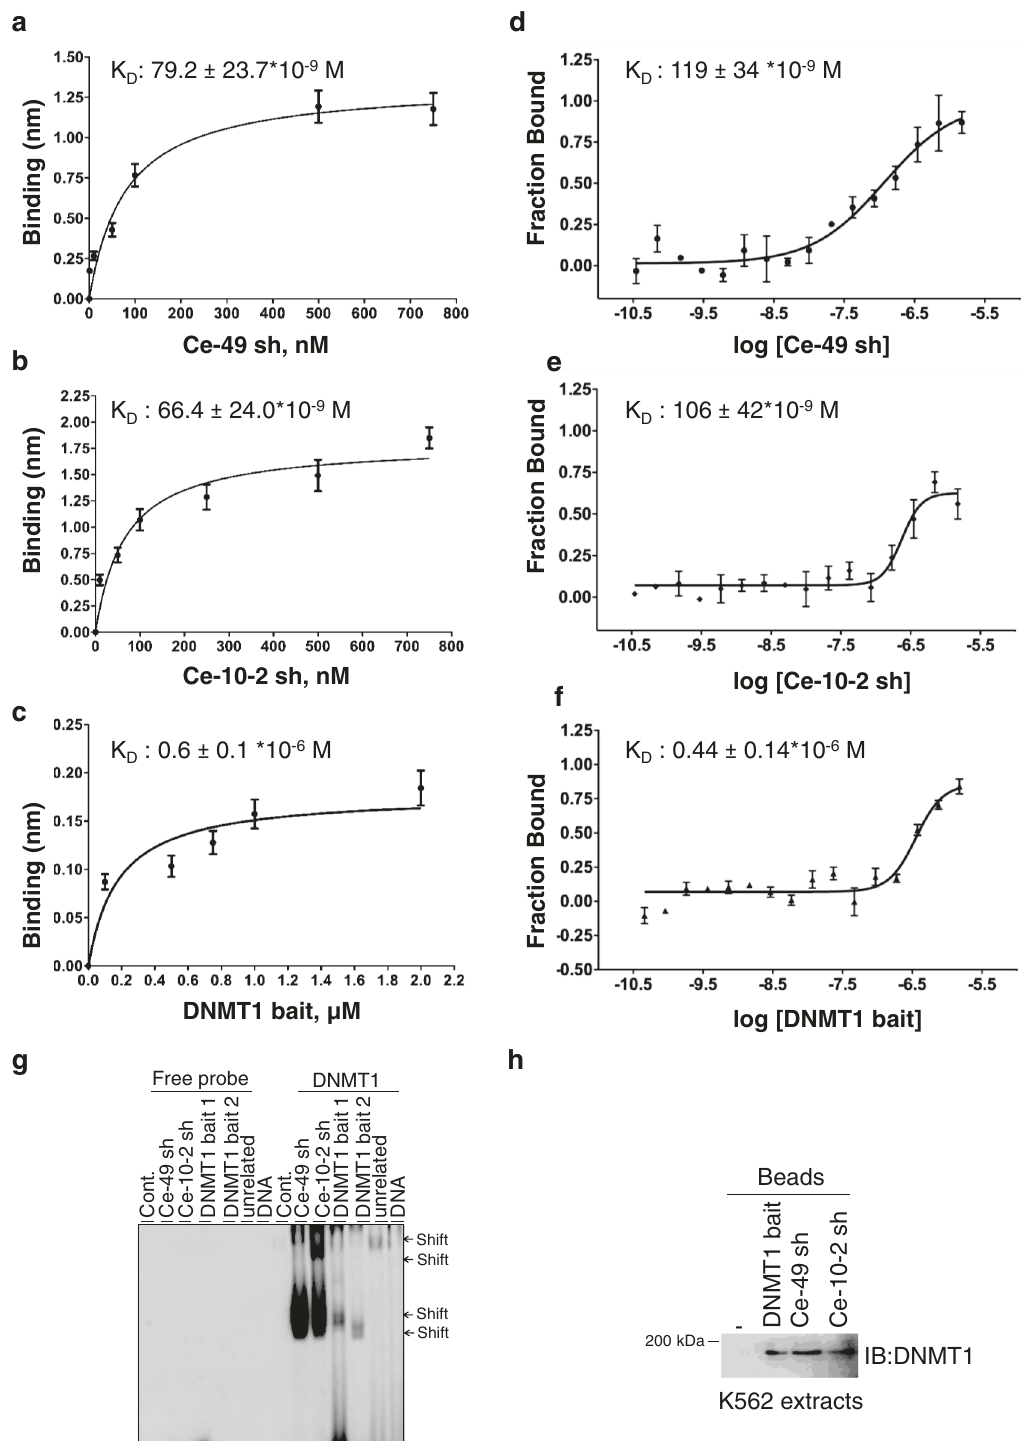
Fig. 3 | AptaDiR af fi nity and in vivo binding to DNMT1. Binding curves derived from BLI analyses of Ce-49 sh ( a ), Ce-10-2 sh ( b ) or DNMT1 bait ( c ). Curves were fi tted with a 1:1 binding model using GraphPad Prism 6. Individual values and the errors calculated by fi tting binding curves using Blitz Pro 1.2 software are